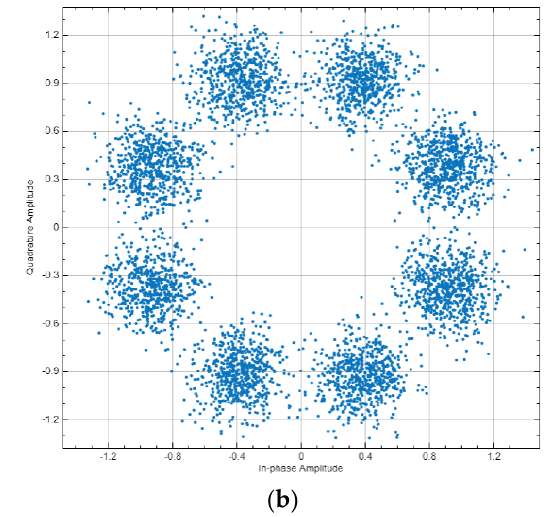
( b ) Figure 17. The CDF of E b /N o +I o of Yamal 90E: ( a ) for QPSK modulation; ( b ) 8PSK modulation. Comparing the E b /N o +I o results with the theoretical QPSK and 8PSK curves in Figure 14, it can be concluded that the BER levels for FSS carriers 8 (183E), 7140E, and 8 (90E) are less than 10 −6 for QPSK and less than 10 −3 for 8PSK. The obtained BER levels and their inter- pretation for each MODCOD are described in detail in further Section 6. Phased or amplitude modulations are often shown using graphics as a constellation